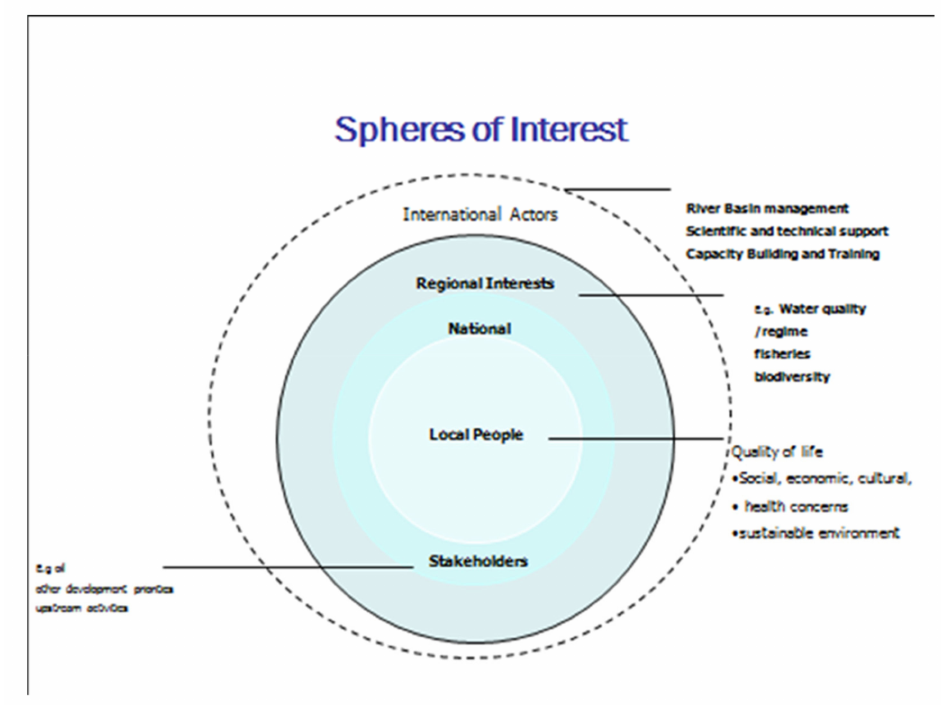
Figure 26. Spheres of influence of stakeholders as presented by the author to the round table discussions among Iraq, Iran and international delegates at the UN Geneva 2003